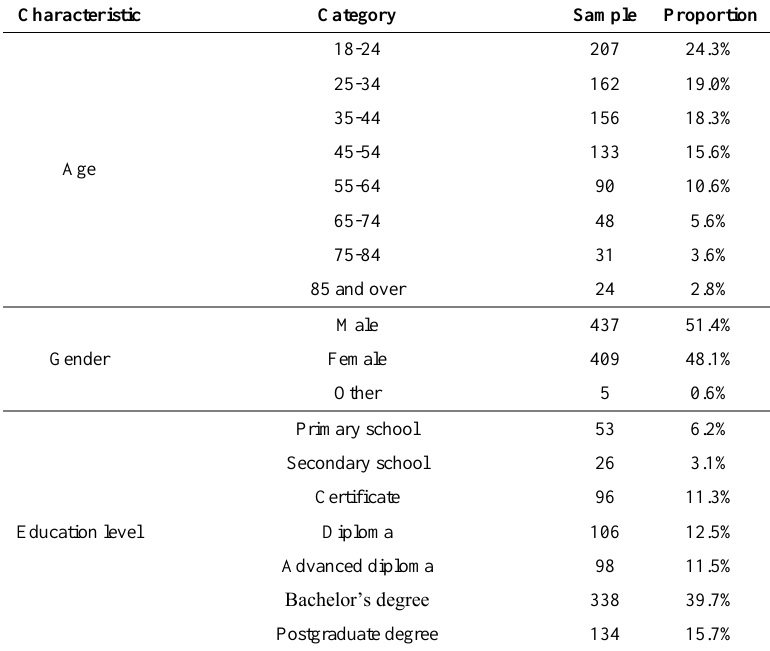
Table 2. Socioeconomic characteristics of the